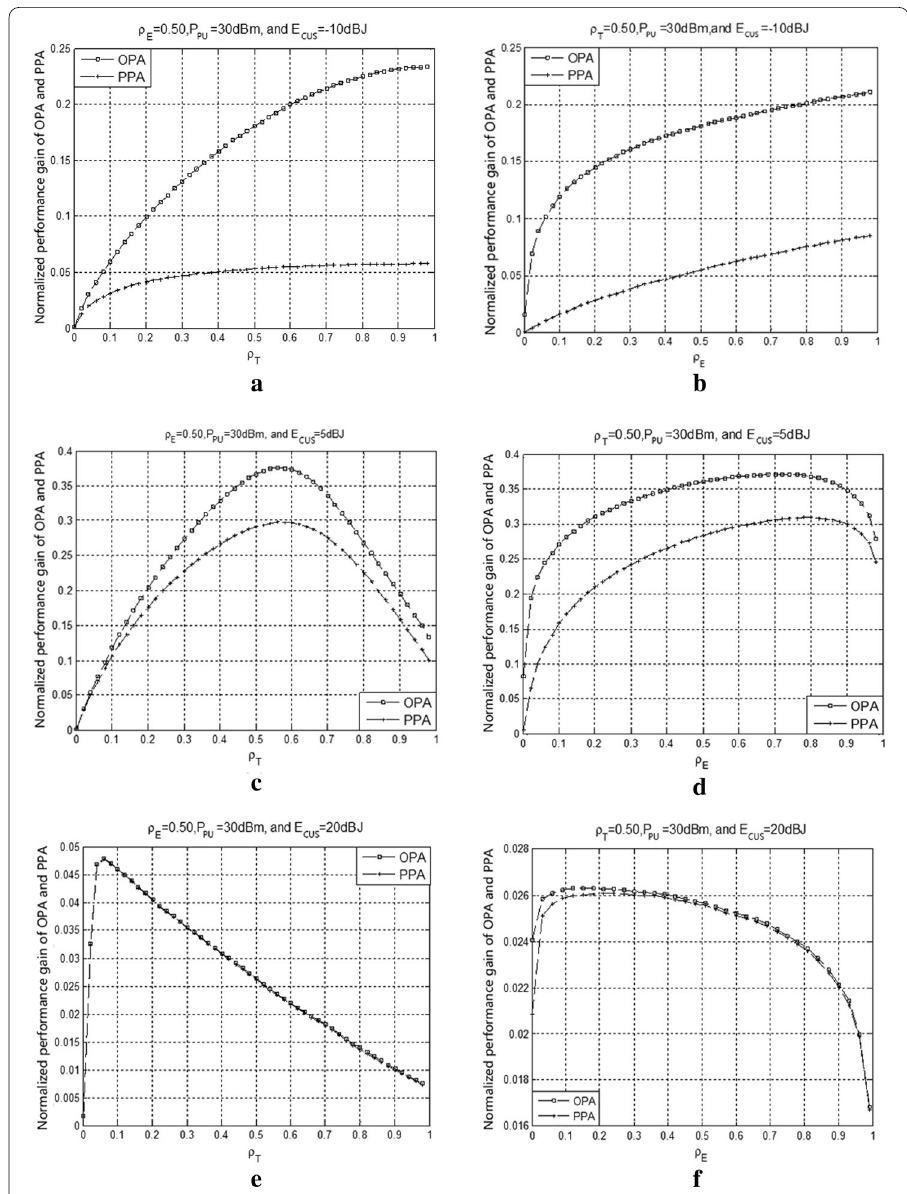
Fig. 8 Performance gain of EE normalized by that of CCR for different algorithms as a function of ρ E and ρ T ,